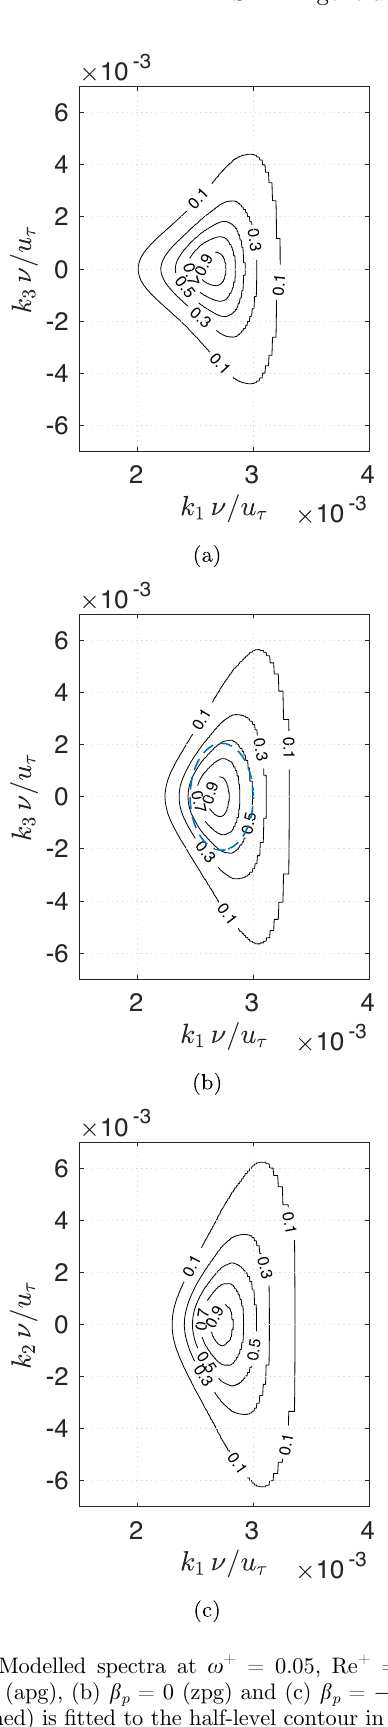
Figure 8. Modelled spectra at x + = 0.05, Re + = 2600 and (a) b p = 10 (apg), (b) b p = 0 (zpg) and (c) b p = (cid:2) 2 (fpg). An ellipse (dashed) is fi tted to the half-level contour in (b).